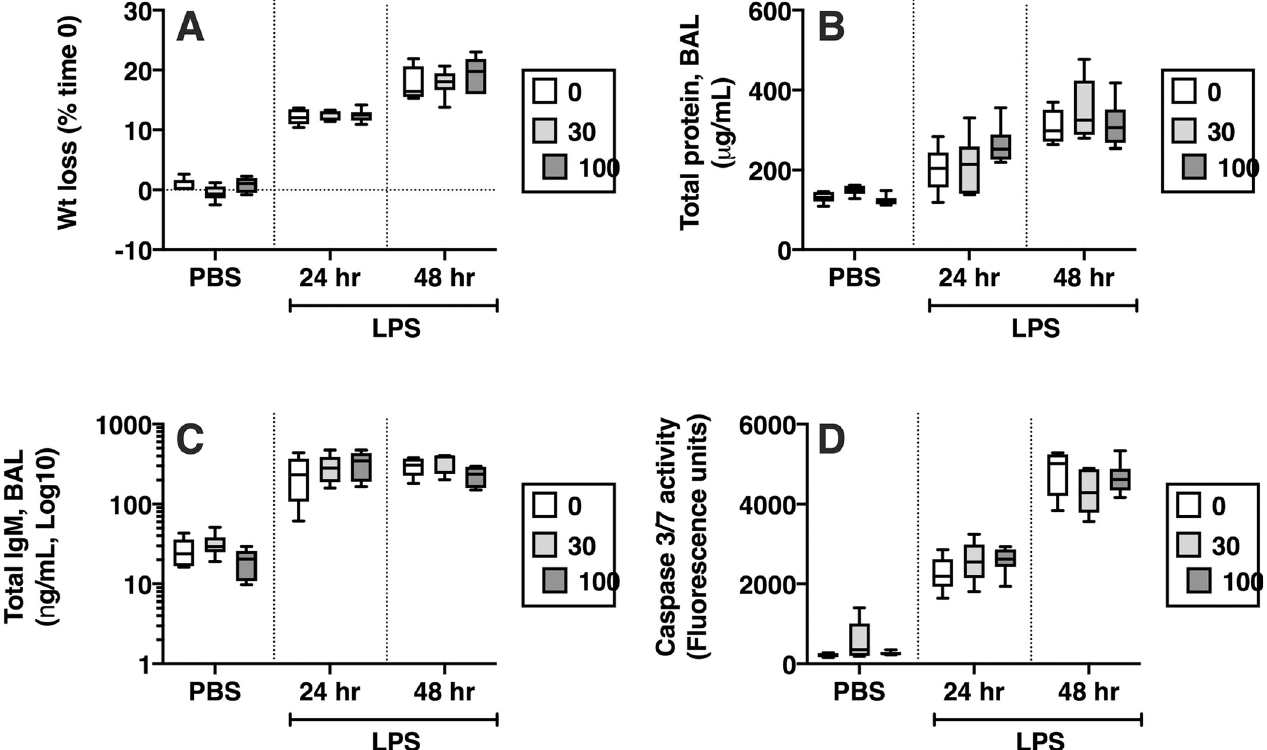
Fig 7. Effects of mut-sFasL in LPS treated mice. C57BL/6 mice received oropharyngeal instillations of either PBS or LPS, 2.5 μ g/mL. Four hours later some of the mice received oropharyngeal instillations of PBS or mut-sFasL at concentrations of 10 and 100 ng/g and were euthanized 24 hours after the initial LPS/PBS instillations (“early” group). Other mice received the PBS or mut-sFasL (same dose range) 24 hours after LPS/PBS and were euthanized 48 hours after the original LPS instillation (“late” group). N = 6 for all groups. Weight loss was similar regardless of treatment (A, percent change from initial weight). The administration of mut-sFasL had no effect total BAL protein (B), BAL IgM (C) or total lung homogenate caspase 3/7 activity (D). Data are reported as box plots, in which the box depicts the 25 th to 75 th percentiles and the lines the min to max range. Data were analyzed by 2-way ANOVA with Dunnett’s post hoc analysis; comparisons were made to 0 ng/mL for each